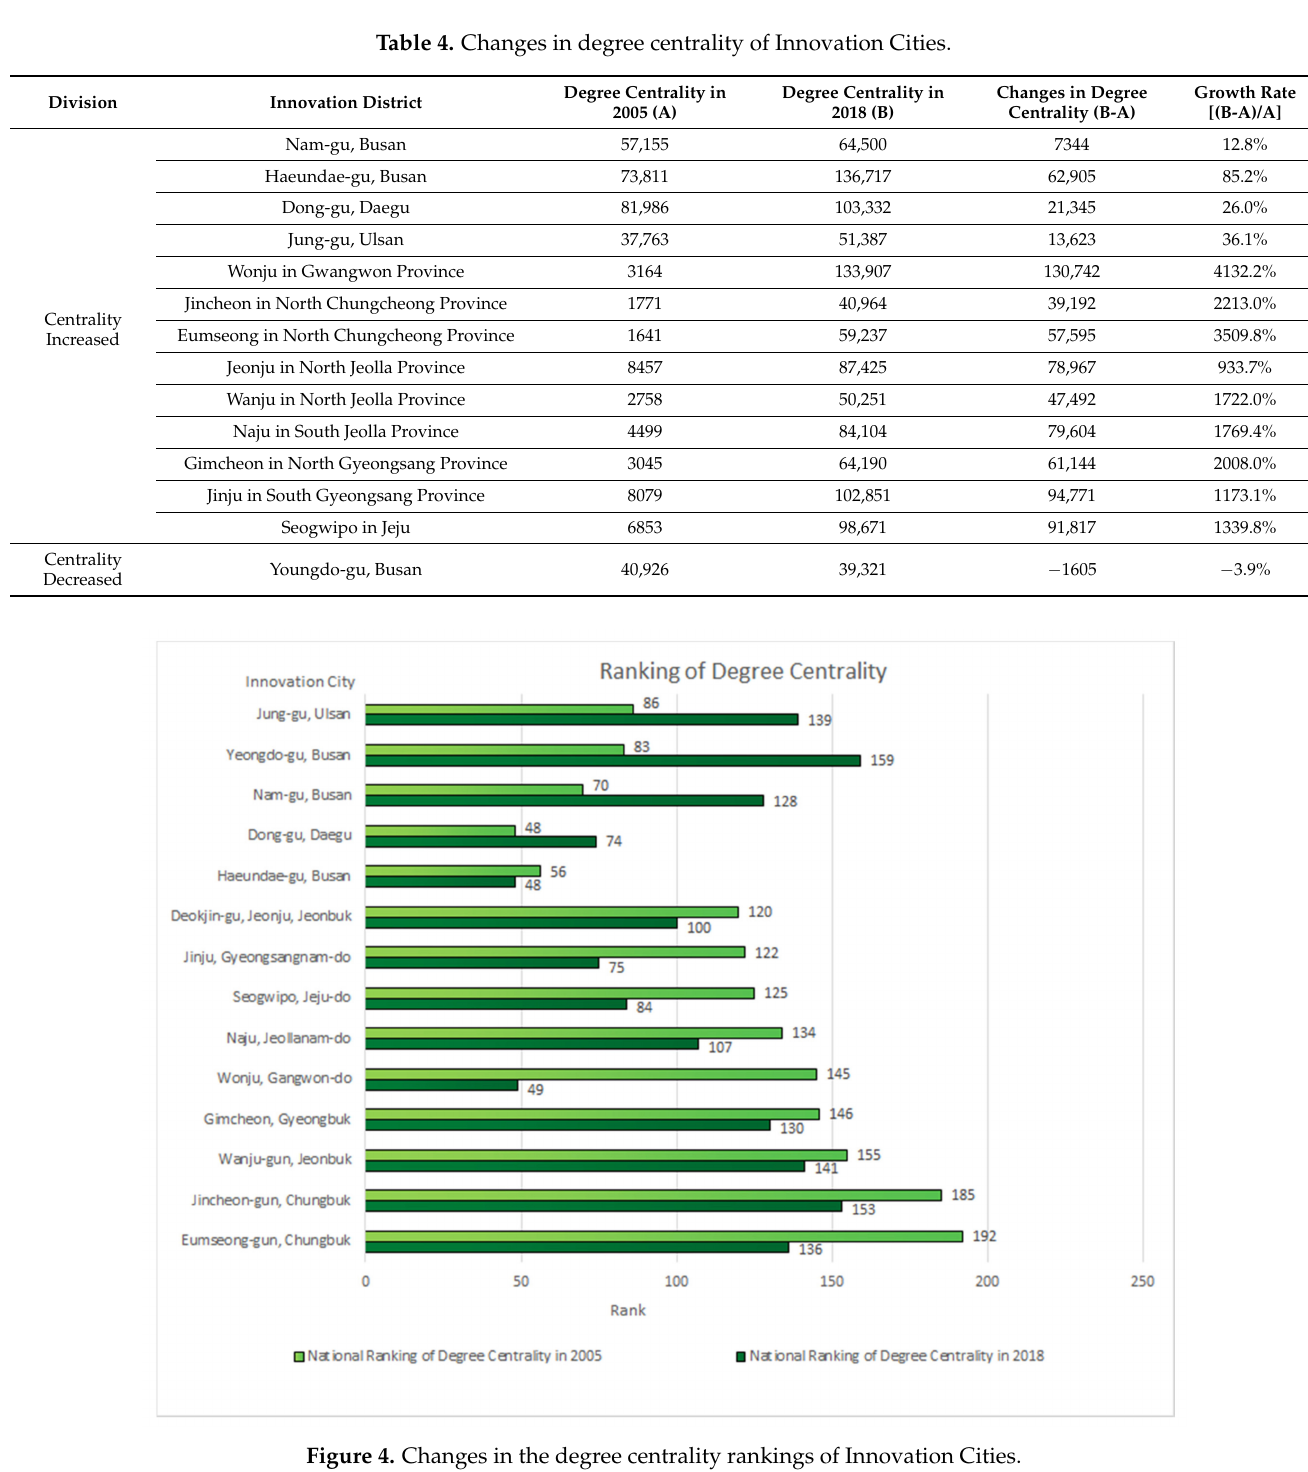
Figure 4. Changes in the degree centrality rankings of Innovation